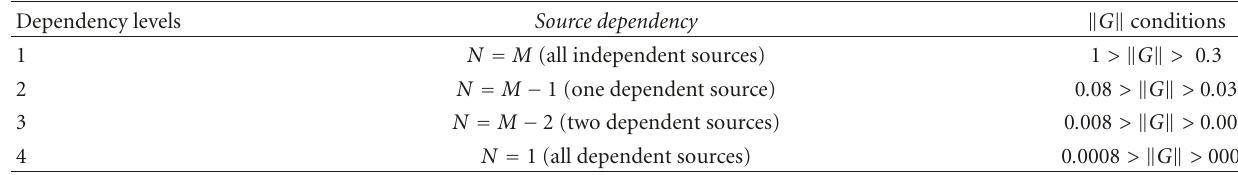
Table 3: Normalized determinant conditions of global matrix for source